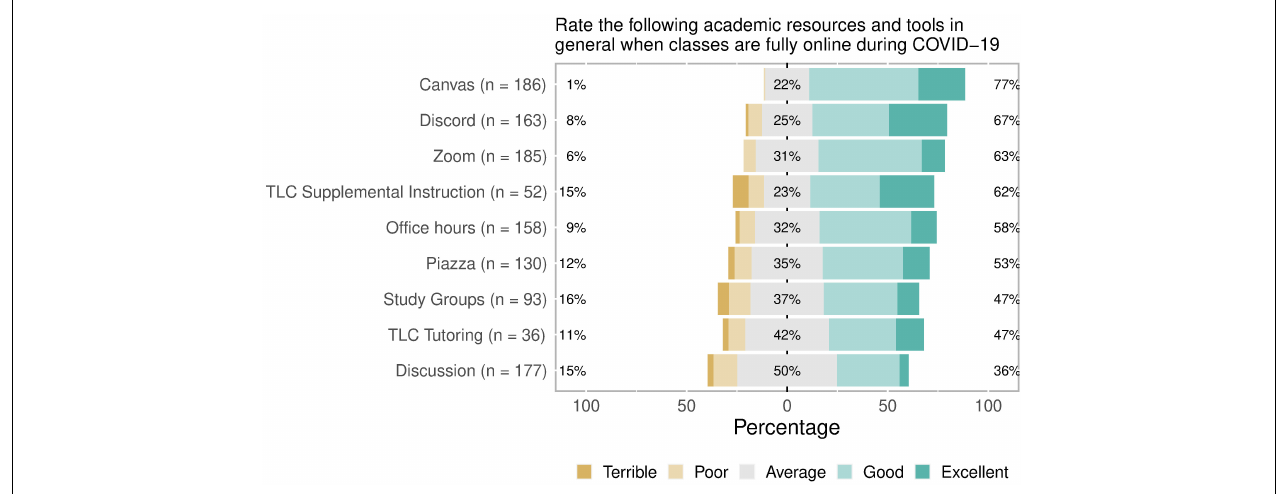
FIGURE 6 | Students’ reported approval ratings of certain academic resources and tools when classes were online.